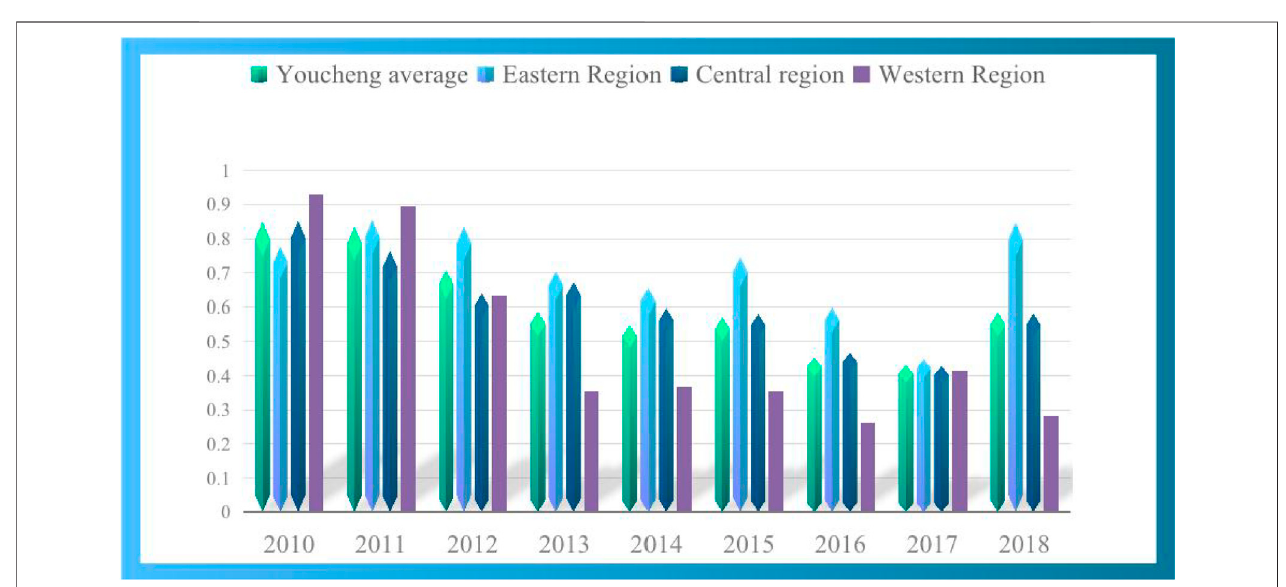
FIGURE 1 | Comparison of static ef fi ciency of green growth in different regions.